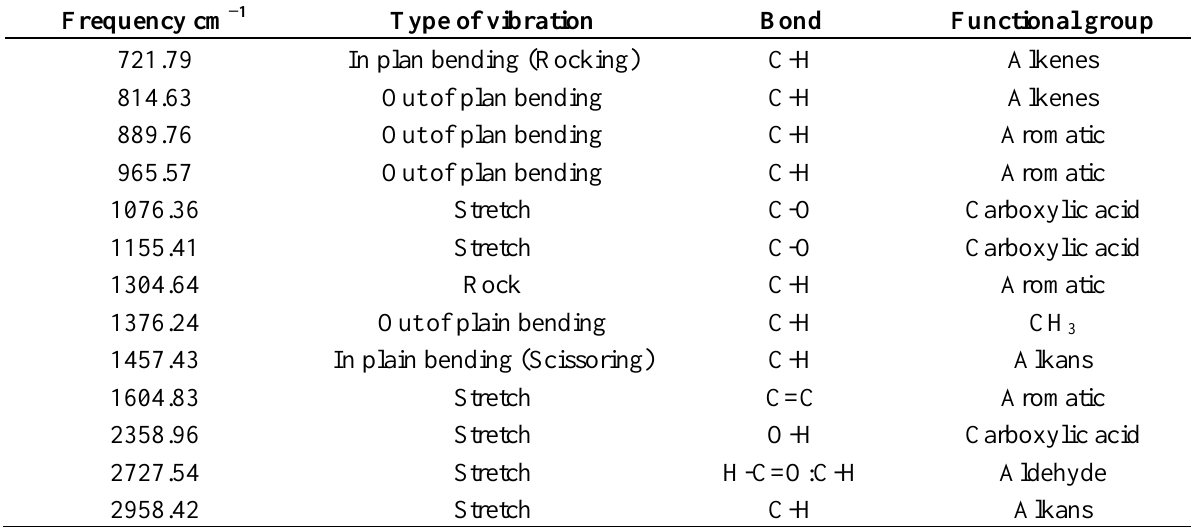
Table 10. Results of analysis of the recycled oil by acid-clay method in local companies in